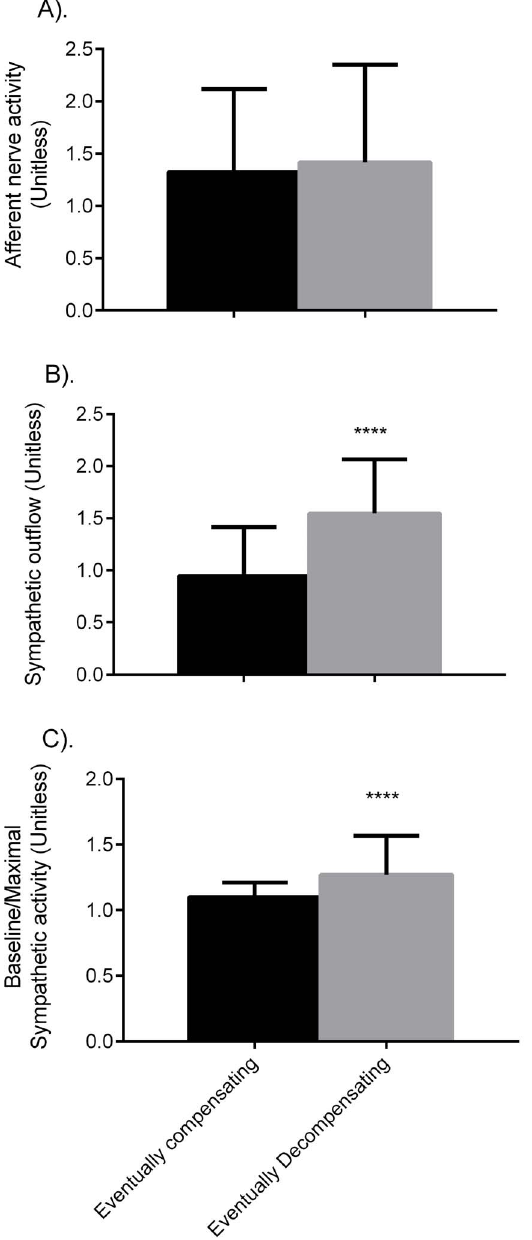
Figure 5. Mean nerve activities in the compensating and decompensating populations. Afferent nerve activity (A) is similar between the groups, while sympathetic outflow (B) and the ratio of baseline sympathetic outflow to maximal sympathetic outflow (C) are significantly different.